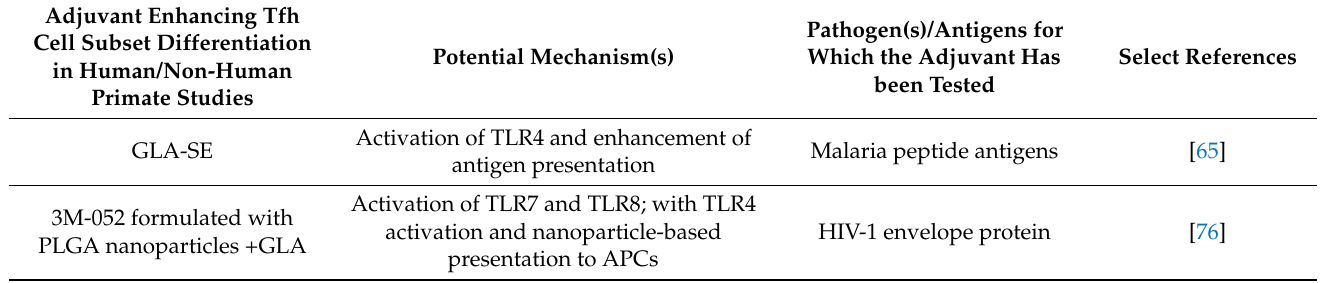
Table 2. Adjuvants enhancing Tfh cell subset differentiation in human/non-human primate studies. Adjuvant Enhancing Tfh Cell Subset